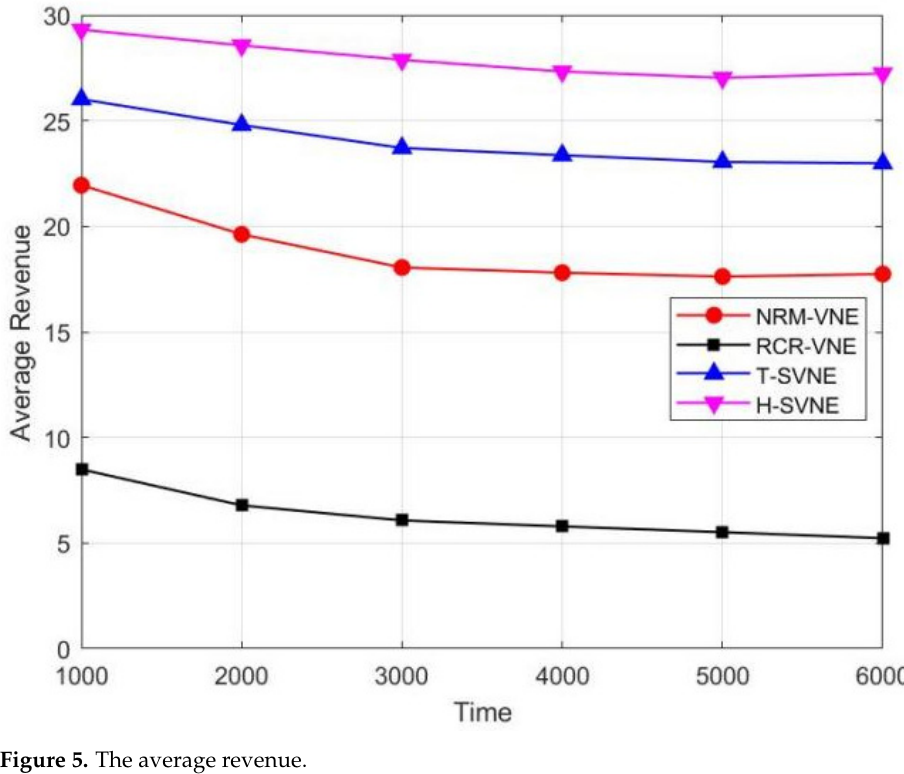
Figure 5. The average revenue.